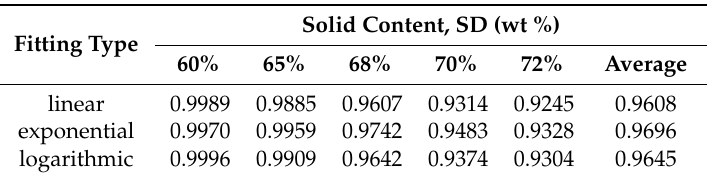
Table 5. Viscosity results of CTB samples under various c/t ratios.